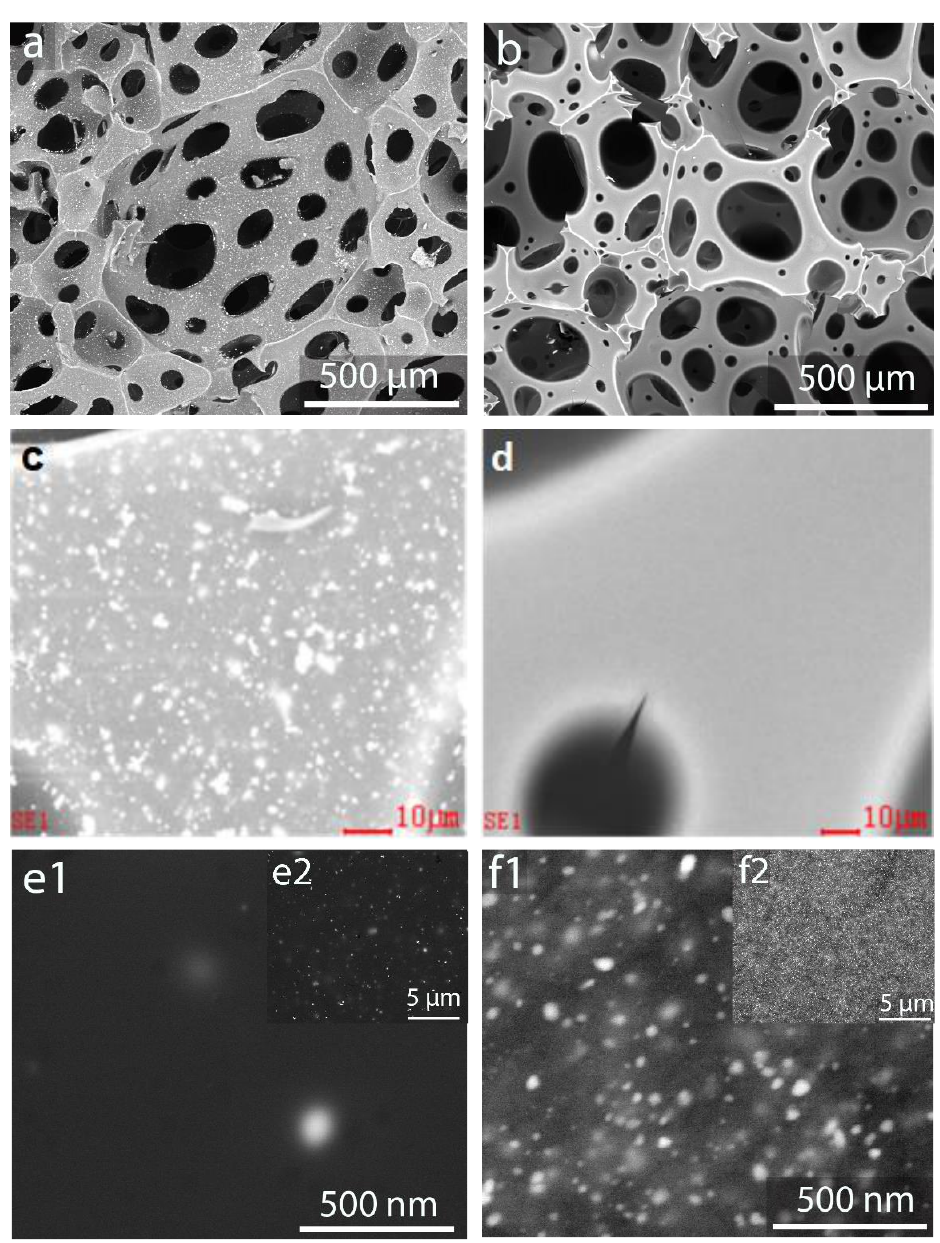
Figure 6. Size and distribution of metal particles in foams SF(Ag) ( a , c , e1,e2 ) and SF(Fe) ( b , d , f1 , f2